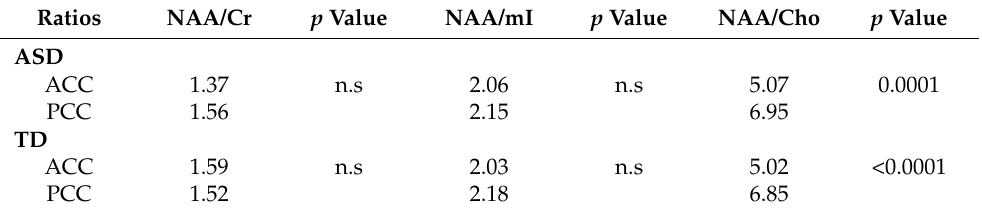
Table 4. Comparing the NAA/Cr, NAA/mI, and NAA/Cho ratios within the ASD ( n = 22) and TD ( n = 43) groups between the ACC and the PCC. p < 0.05 considered significantly